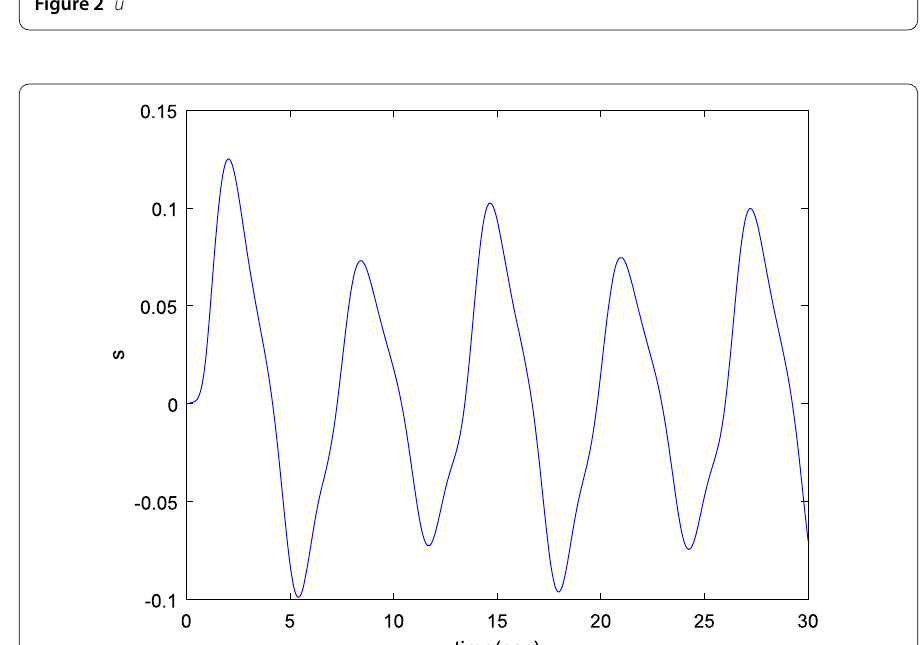
Figure 3 Unmodeled